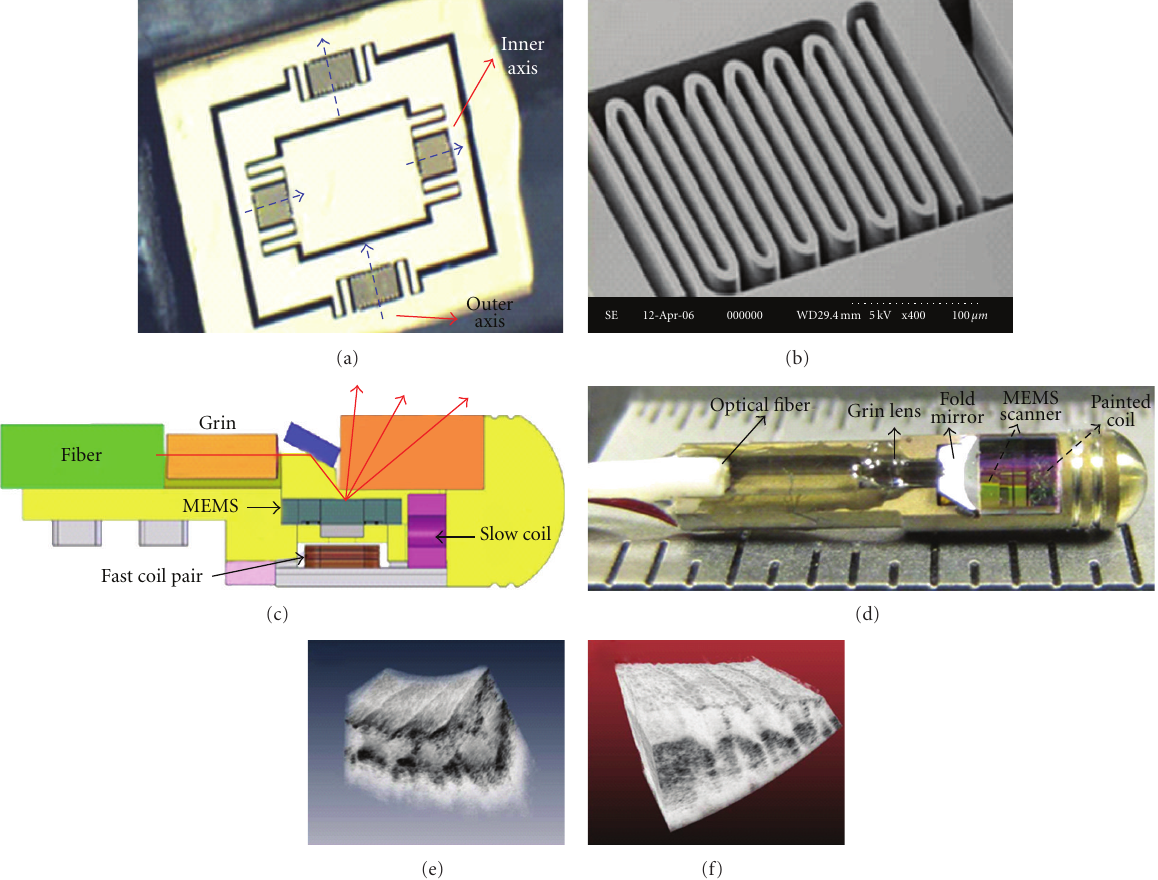
Figure 5: Electromagnetic MEMS OCT reported by Kim et al. (a) (b)SEMs of the MEMS mirror, (c) (d)design and packaging of the probe, (e) (f) 3D image of finger tip. Reprint permission granted by OSA.